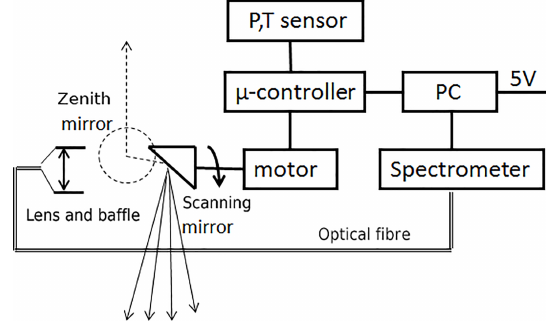
Figure 1. Schematic diagram of the SWING